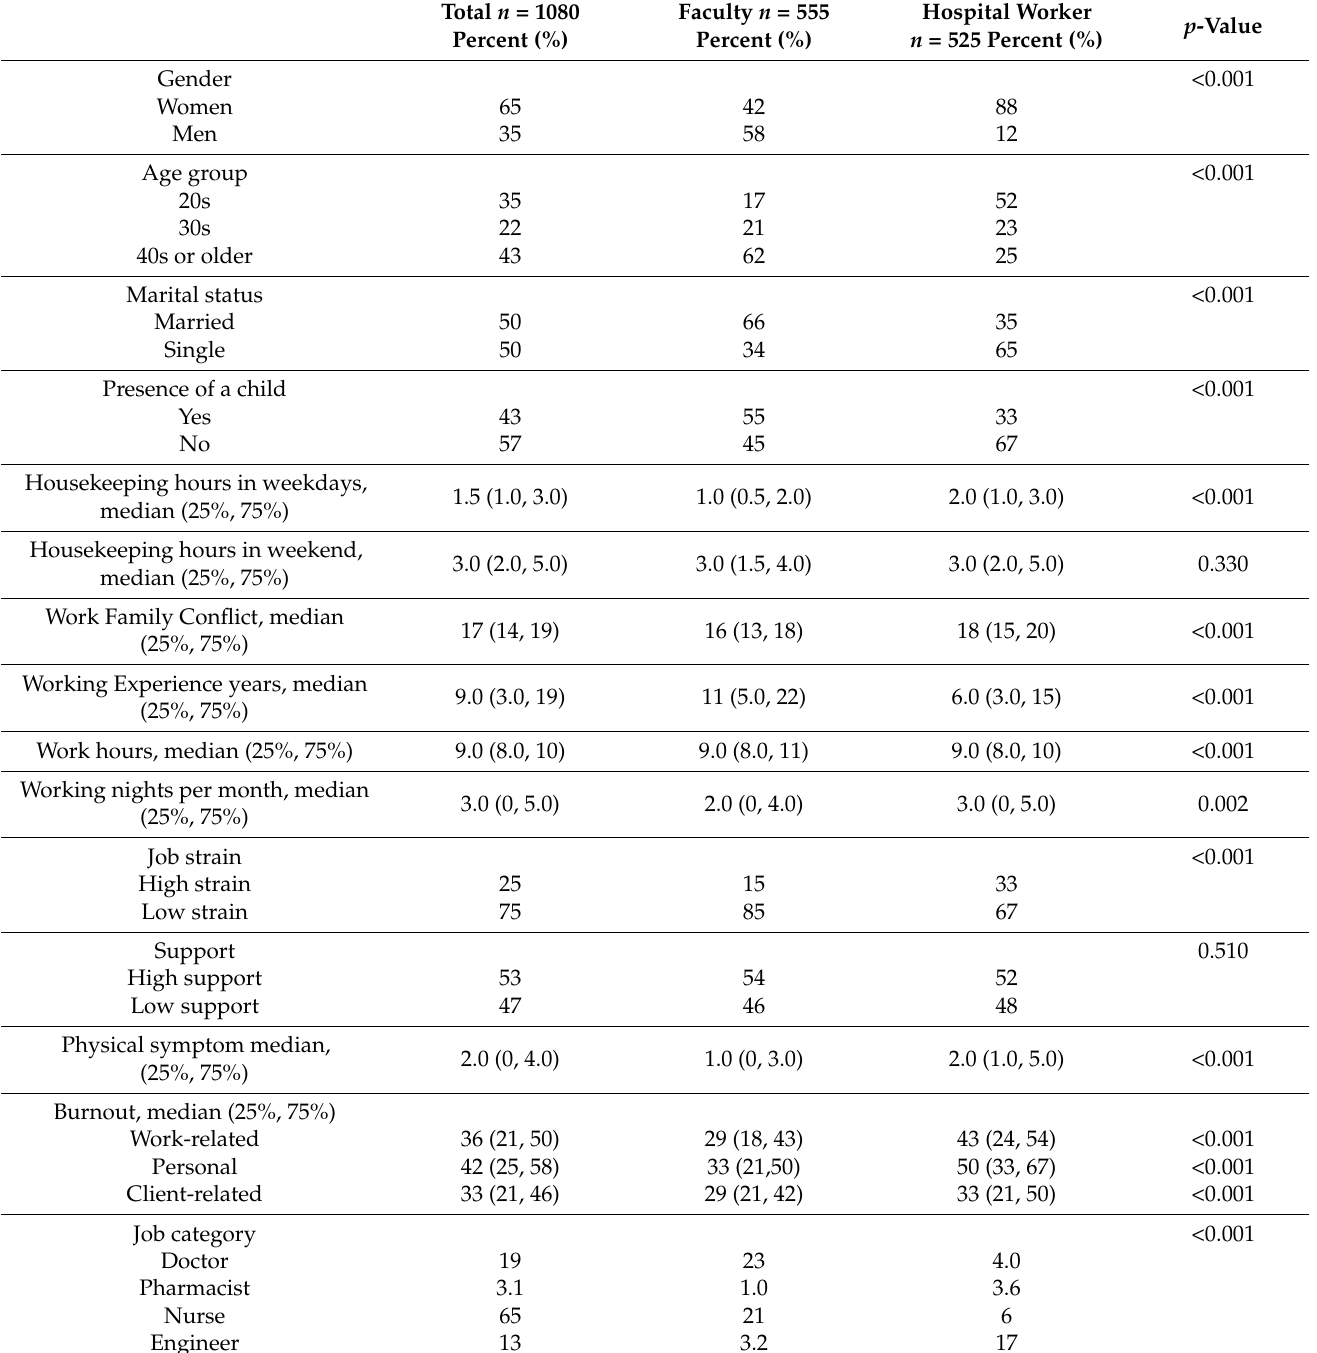
Table 1. Baseline characteristics and working conditions according to